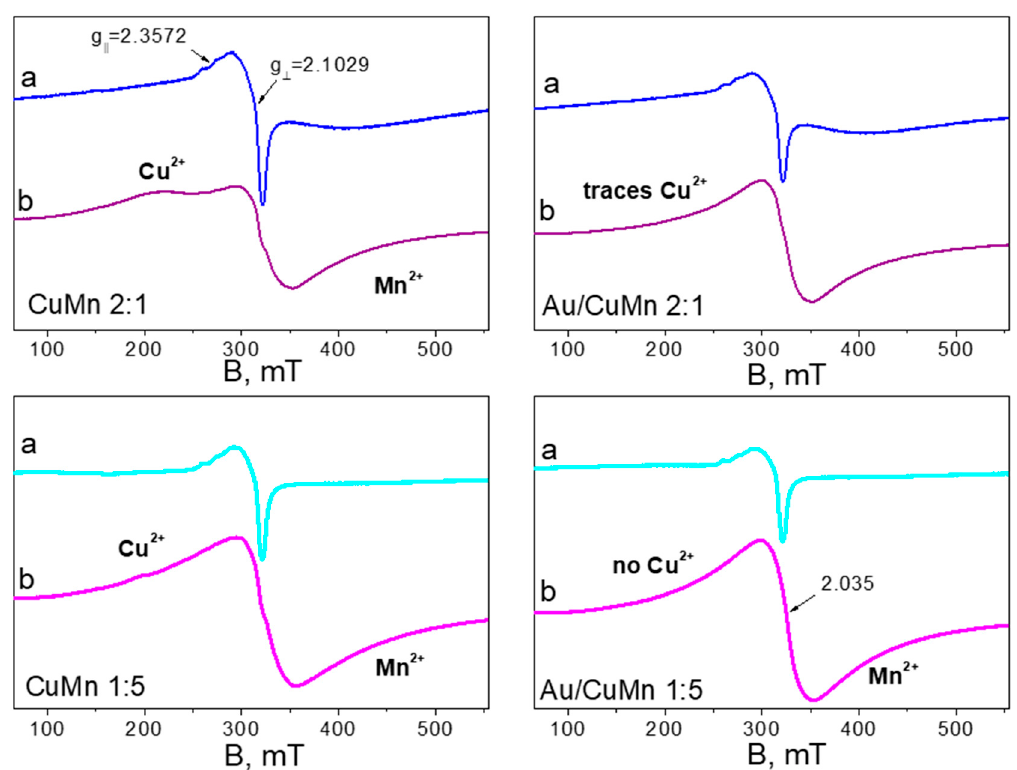
Figure 7. The Electron paramagnetic resonance (EPR) spectra of alumina-supported CuMn and Au/CuMn catalysts with a Cu:Mn ratio of 2:1 and 1:5: ( a ) fresh samples; ( b ) samples after WGS reaction.